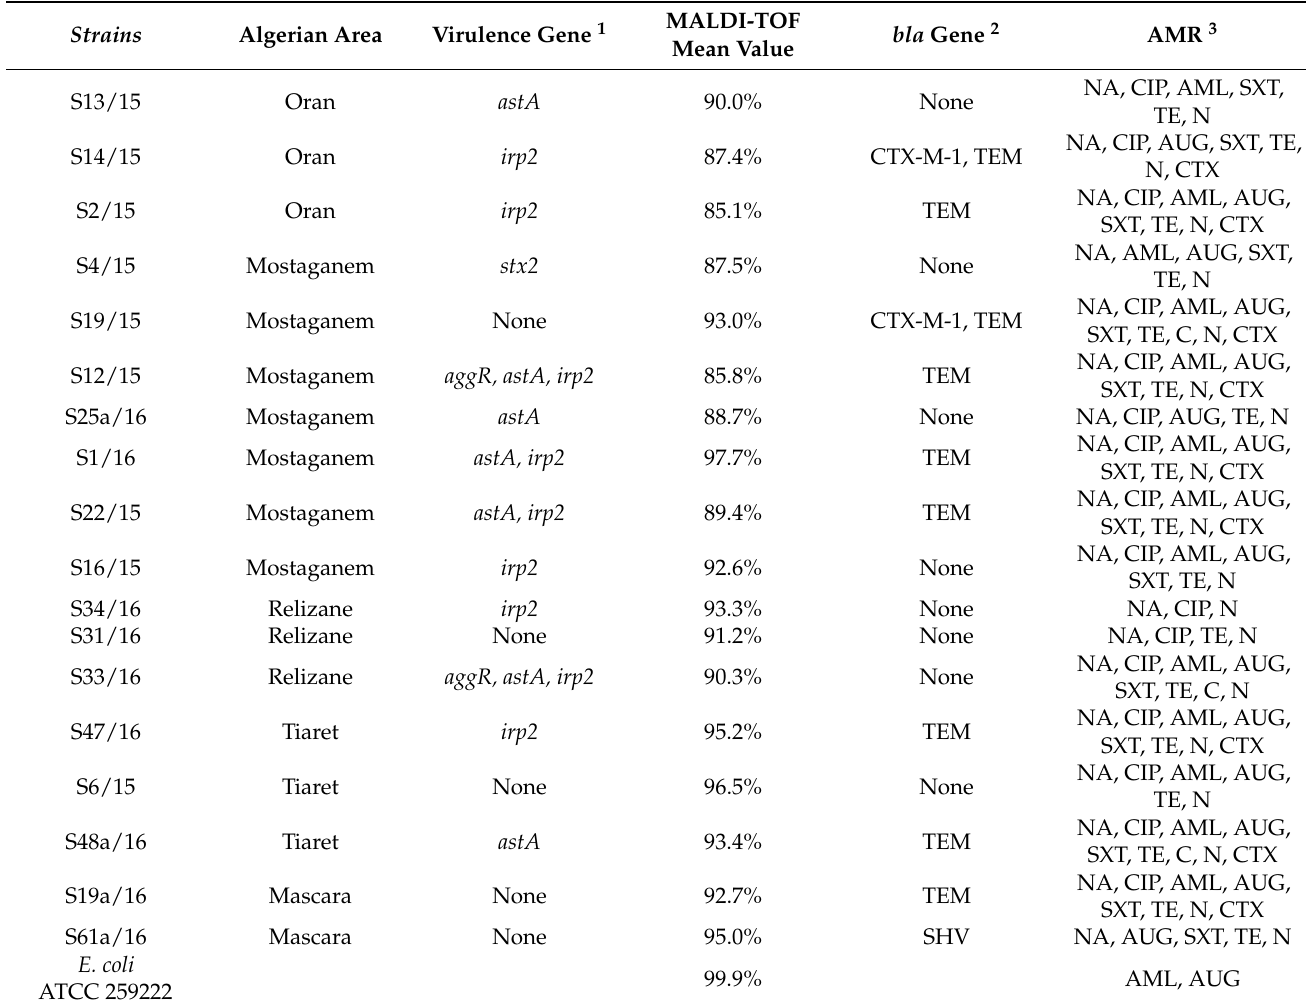
Table 1. Characteristics of E. coli